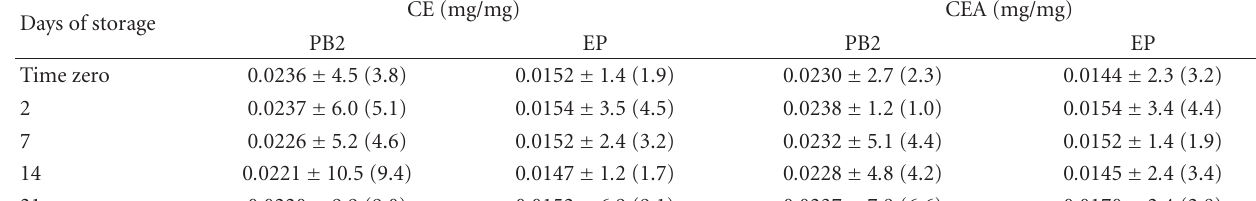
Table 1: Stability of the constituents procyanidin B2 (PB2) and epicatechin (EP) of the dried extract of Guazuma ulmifolia . Mean ± SD (RSD %).